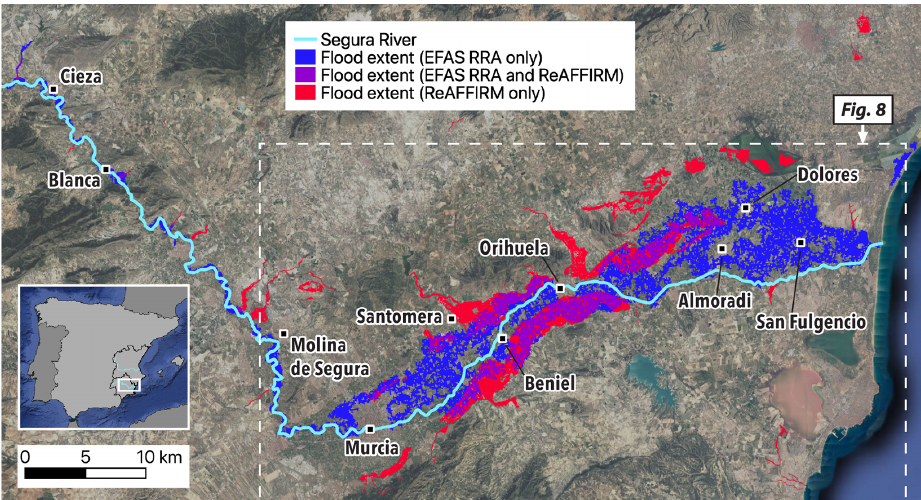
Figure 4. Fluvial flood extents simulated by EFAS RRA (blue) and flash flood extents simulated by ReAFFIRM (red). At the locations where the flood extents simulated by the two methods overlap (purple), the flash flood extents and impacts simulated by ReAFFIRM are automatically removed to avoid a systematic overestimation of the compound impacts (see Sect. 3.3). The dashed rectangle indicates the area displayed in Fig. 8. Map data © Google Earth 2015. Table 2. Summary of simulated fluvial flood impacts (EFAS RRA) and reported flood impacts (CRAHI, 2019; CCS, 2020; DGPCE, 2019) in selected municipalities. Critical infrastructure (CI) categorised as health facilities (HF), education facilities (EF), and mass-gathering sites